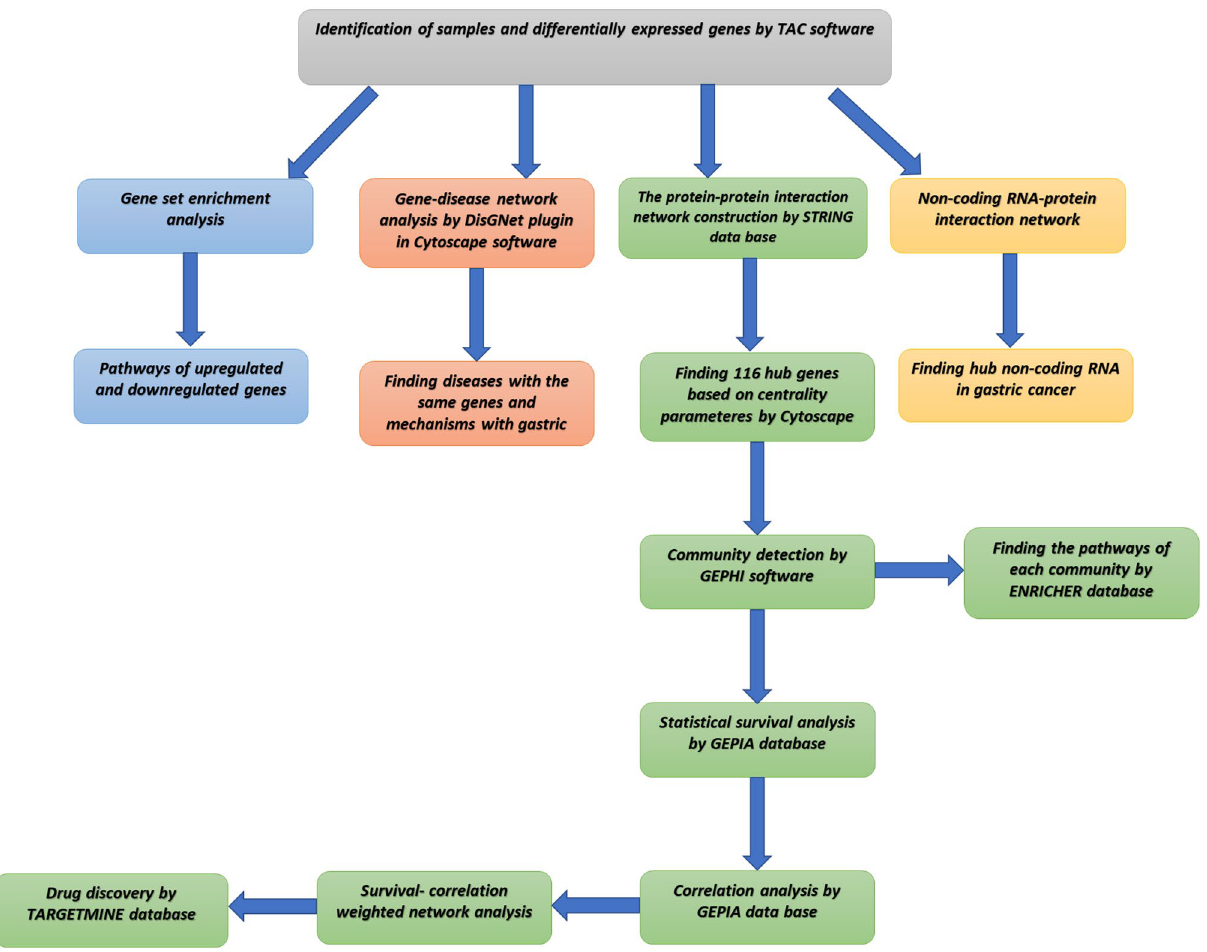
Figure 1. Method diagram showing the summary of applied steps in this